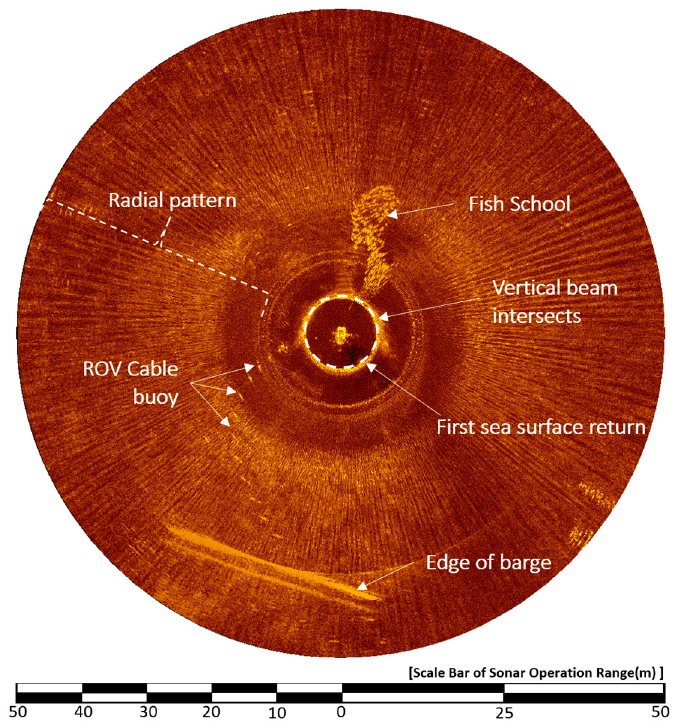
Figure 17. Result image of the 10° upward HHM.